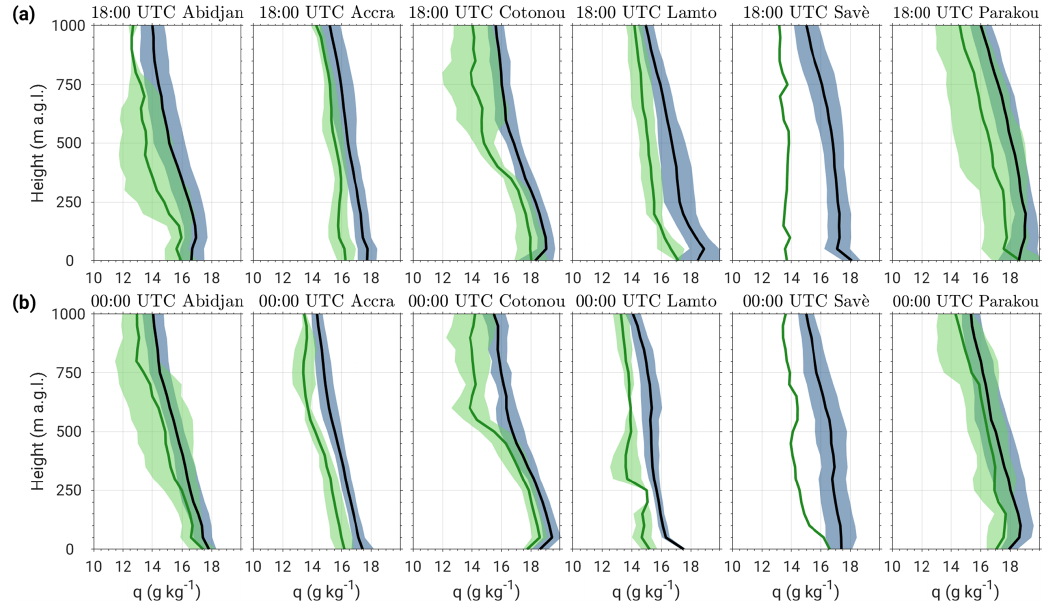
Figure 8. The same as Fig. 7 but for specific humidity ( q